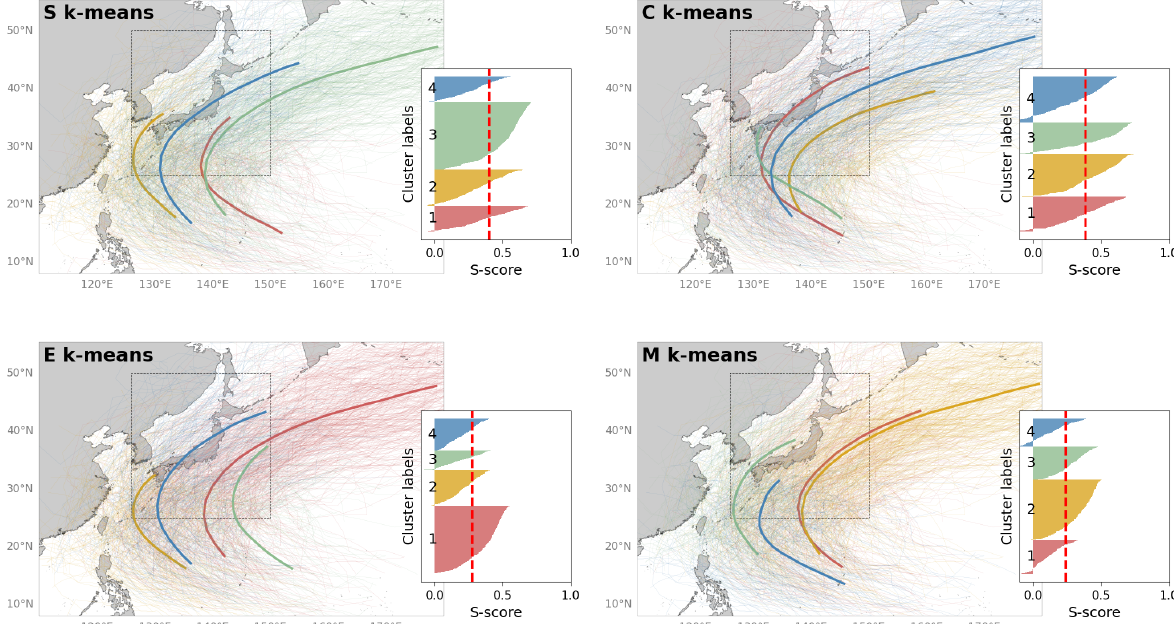
Figure 5. Results of the TC experiment for clustering tropical cyclone paths. The pattern was revealed by S, C, E, and M k -means, with k = 4. Input data are the best TC tracks obtained by the JMA from 1951–2020. Only TCs that passed the dashed box in the map are used to feed the k -means. Thus, a total of 863 TC tracking data points are used. The left side of each panel shows the general silhouette analysis results, where the x axis indicates the score (S score), and the y axis presents the labels of clusters numbered 1–4. The centroid TC path is illustrated by the bold line, and the color is consistent with that in the silhouette diagram.